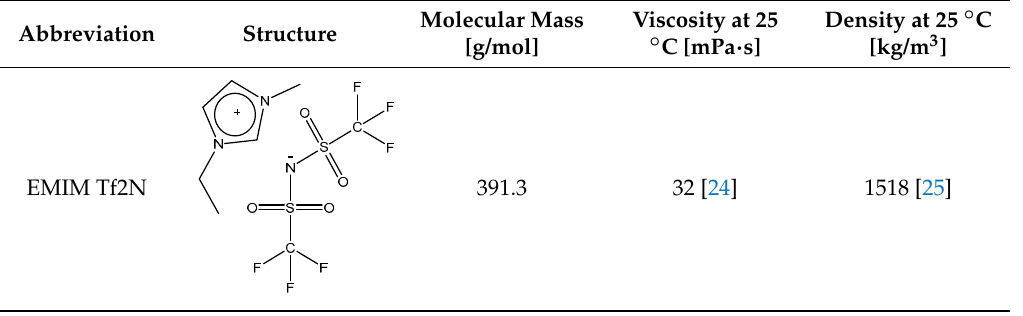
Table 2. Polyacrylonitrile (PAN) membranes used as support for supported ionic liquid membranes (SILMs): differences in preparation conditions and resulting porous layer